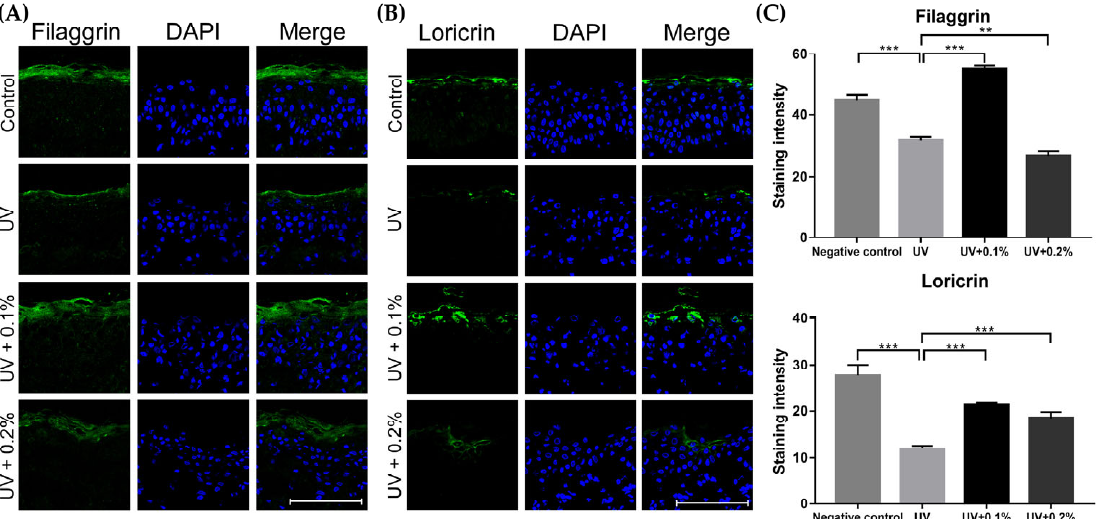
Figure 6. Comparison of filaggrin ( A ) and loricrin ( B ) expression using immunofluorescence stain ‐ ing. Treatments with 0.1% (UV + 0.1%) and 0.2% (UV + 0.2%) H.ECM TM liposome increased the ex ‐ (UV + 0.1%) and 0.2% (UV + 0.2%) H.ECM TM liposome increased the expression of filaggrin and loricrin that were reduced pression of filaggrin and loricrin that were reduced by UVB irradiation. Moreover, the expression by UVB irradiation. Moreover, the expression after 0.1% H.ECM TM liposome treatment was significantly higher than with after 0.1% H.ECM TM liposome treatment was significantly higher than with 0.2% H.ECM TM liposome 0.2% H.ECM TM liposome ( C ). Scale bar indicated 100 µ m. ** p < 0.01, *** p < ( C ). Scale bar indicated 100 μ m. ** p < 0.01, *** p < 0.005.